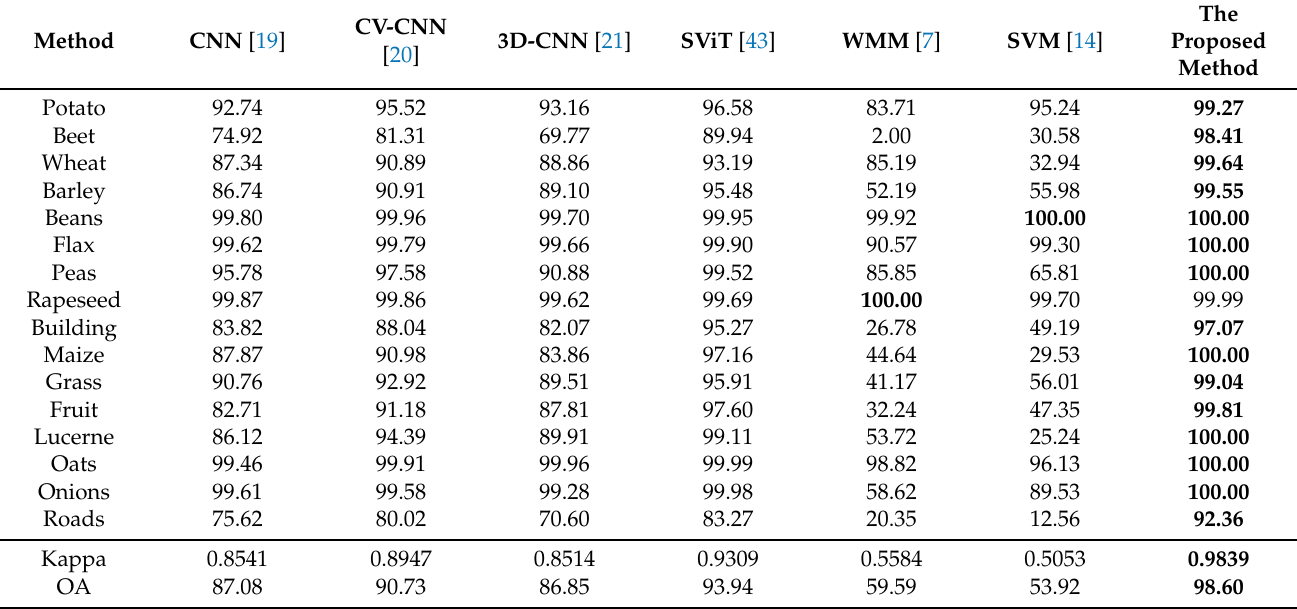
Table 4. Classification results on the C-band Flevoland